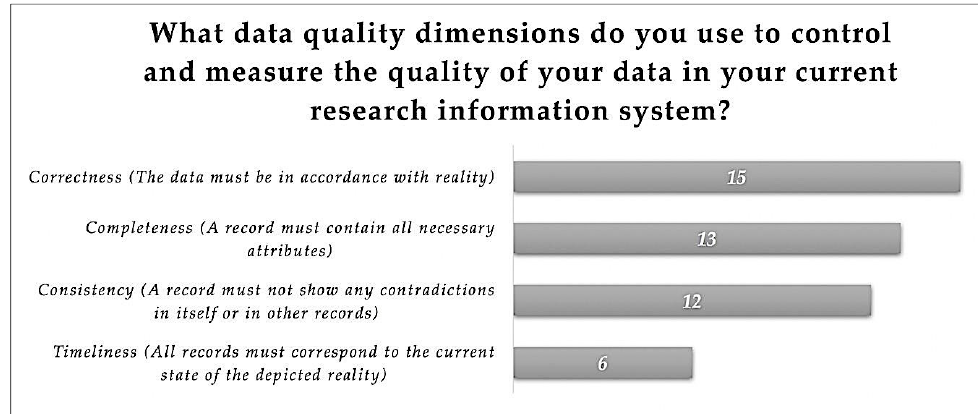
Figure 6. Data quality dimensions for checking and measuring data quality in CRIS ( N = 17 ).